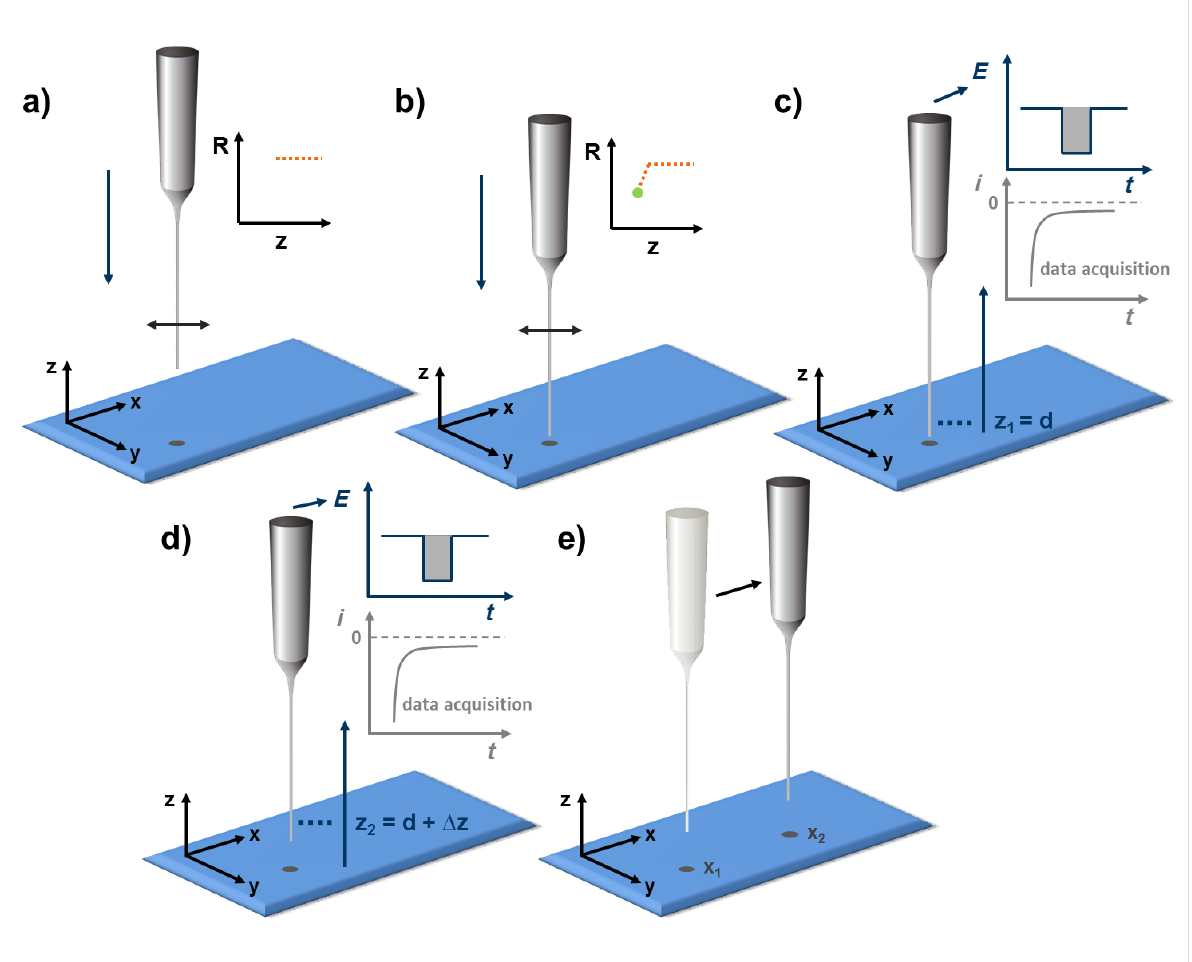
Figure 4: Concept of the 4D SF/CD-RC-SECM. Similar to the 4D SF/CD mode the tip is positioned within the shearforce-interaction regime by means of a z-approach curve (a and b). Data acquisition is performed in subsequent retraction steps (c and d) set out from the point of closest approach. To additionally implement the redox competition mode, a variable potential pulse profile is performed at each tip-to-sample distance. During a competi- tion pulse tip and sample compete for the oxygen inside the gap and a time-dependent current decay curve is recorded at the tip enabling a time- resolved analysis of the oxygen concentration within the gap. After completion of the retraction the tip is moved to the next grid point (e) and the procedure is repeated starting with the shearforce-based positioning